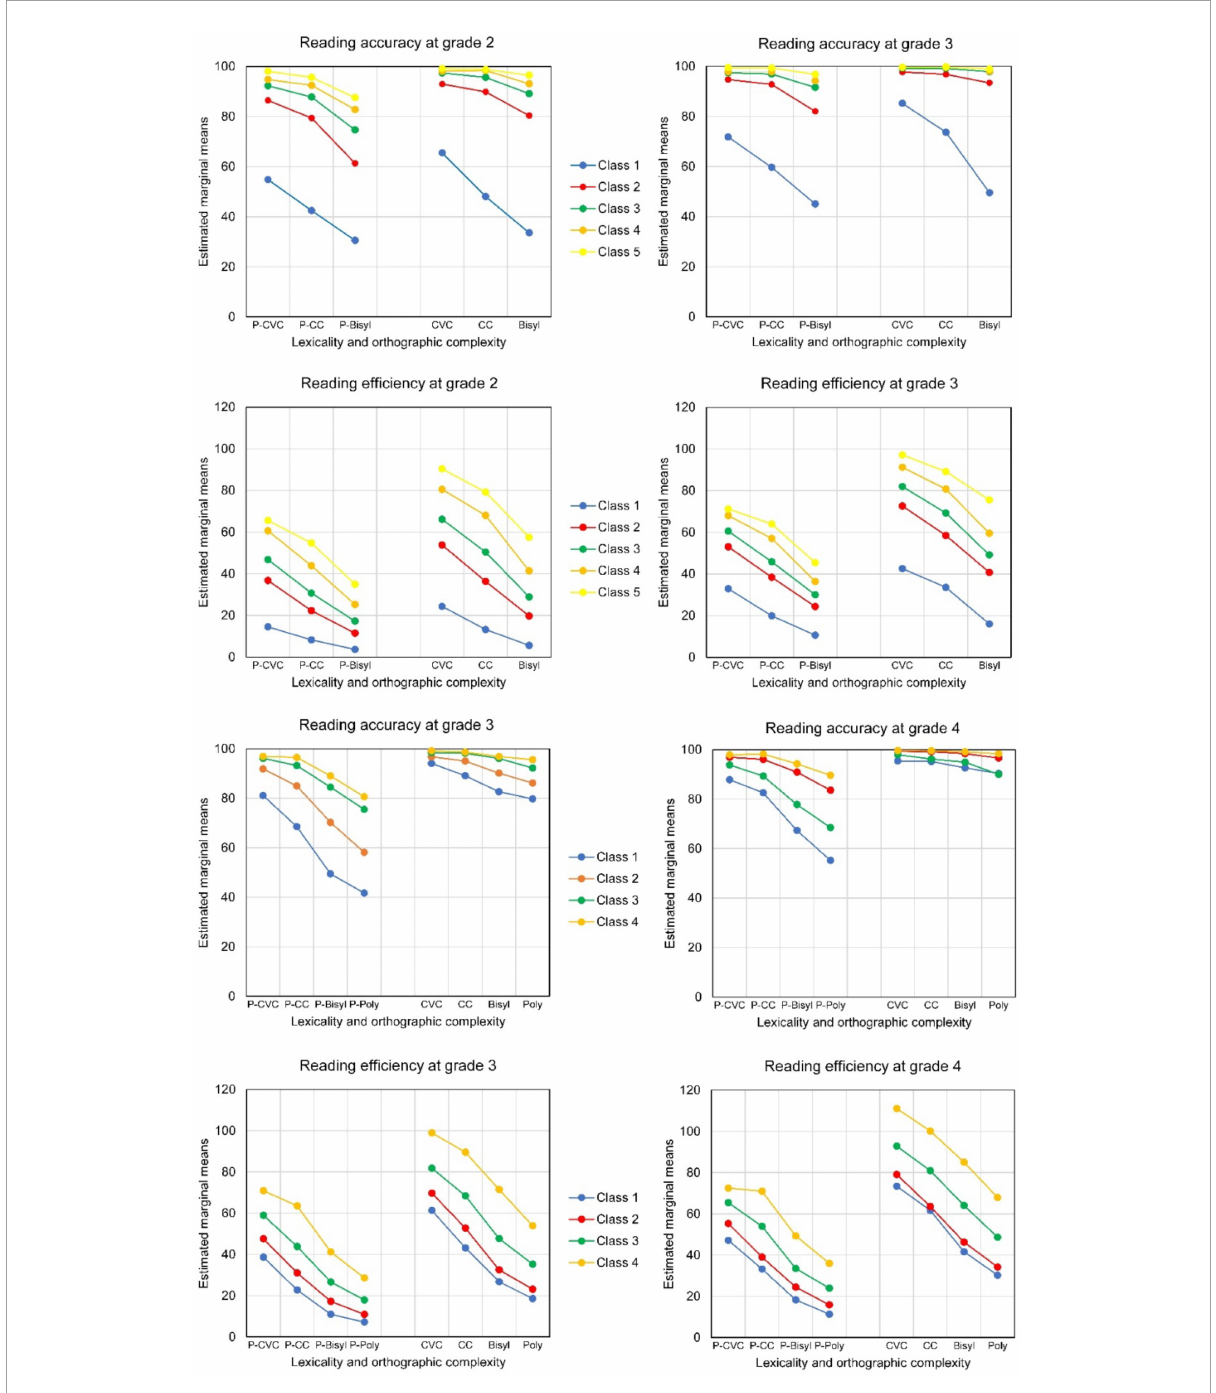
FIGURE6 Average profiles of Reading Accuracy (% correct) and Efficiency (number of words per minute) of 2-year follow-up of the Latent Classes in Cohort 1 (Grade 2 and 3) and 2 (Grade 3 and 4). In each plot pseudowords to the left, real words to the right.